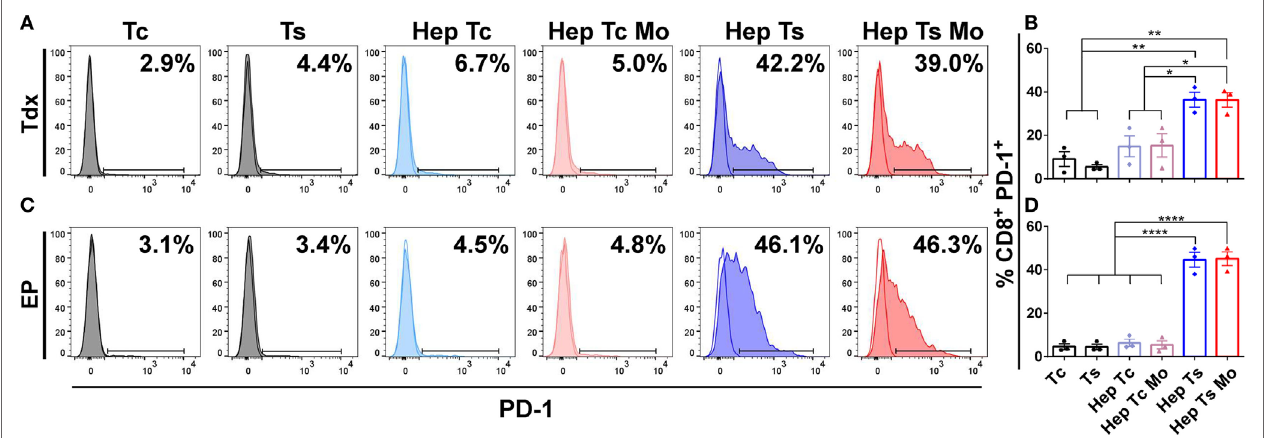
FigUre 2 | (a,c) Representative histograms of the flow cytometry data of CD8 + PD-1 + Tdx (a) and EP (c) HBV-specific TCR T cells at 24 h are shown. Tinted and non-tinted histograms, respectively, represent the stained sample or matched isotype control, where a horizontal line is drawn based on the isotype control to demarcate for PD-1 + cells. Percentage values of CD8 + PD-1 + cells are indicated. (B,D) Bar plots show the mean ± SEM of CD8 + PD-1 + TCR T cells of three donors for Tdx (B) or EP (D) HBV-specific TCR T cells; bars are drawn where a comparison was made with * P ≤ 0.05, ** P ≤ 0.01 and **** P ≤ 0.0001. Statistical significance was evaluated by a one-way ANOVA with Holm-Sidak’s multiple comparisons test. EP, mRNA-electroporated; HBV, hepatitis B virus; Hep, HepG2-preS1-GFP; Mo, monocyte; Tc, control T cell; TCR T cells, T cell receptor-redirected T cells; Tdx, transduced; Ts, HBV-specific T